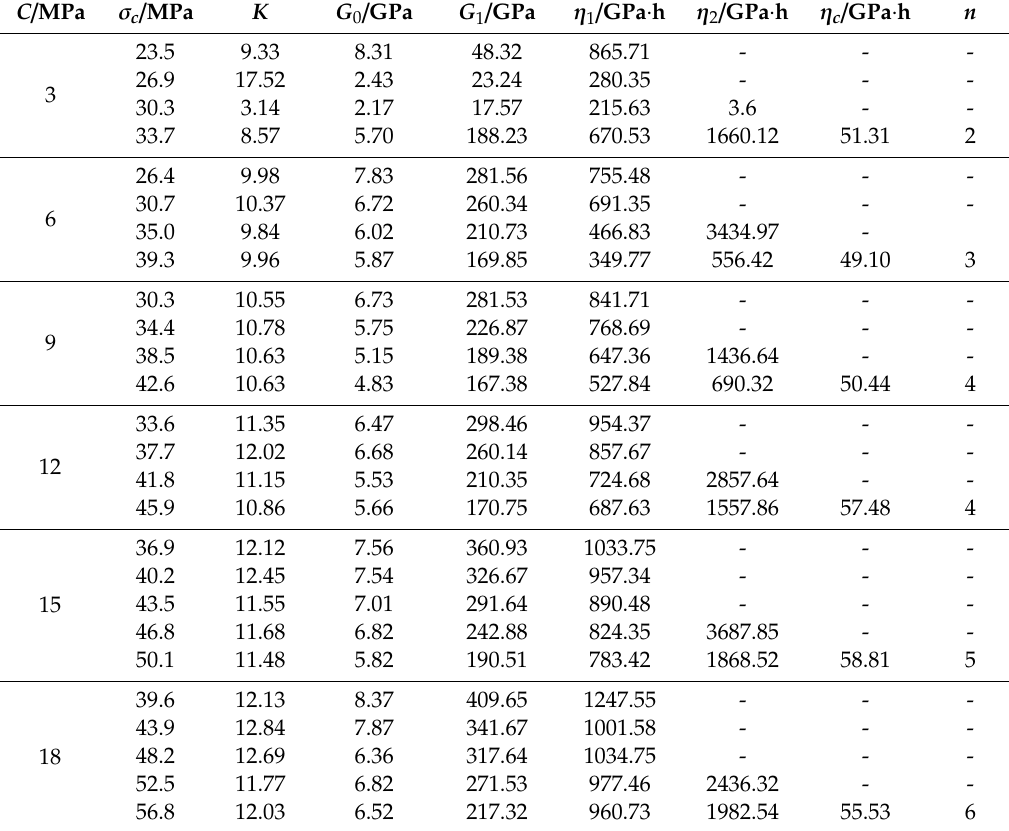
Table 4. Creep parameters of AS under di ff erent confining